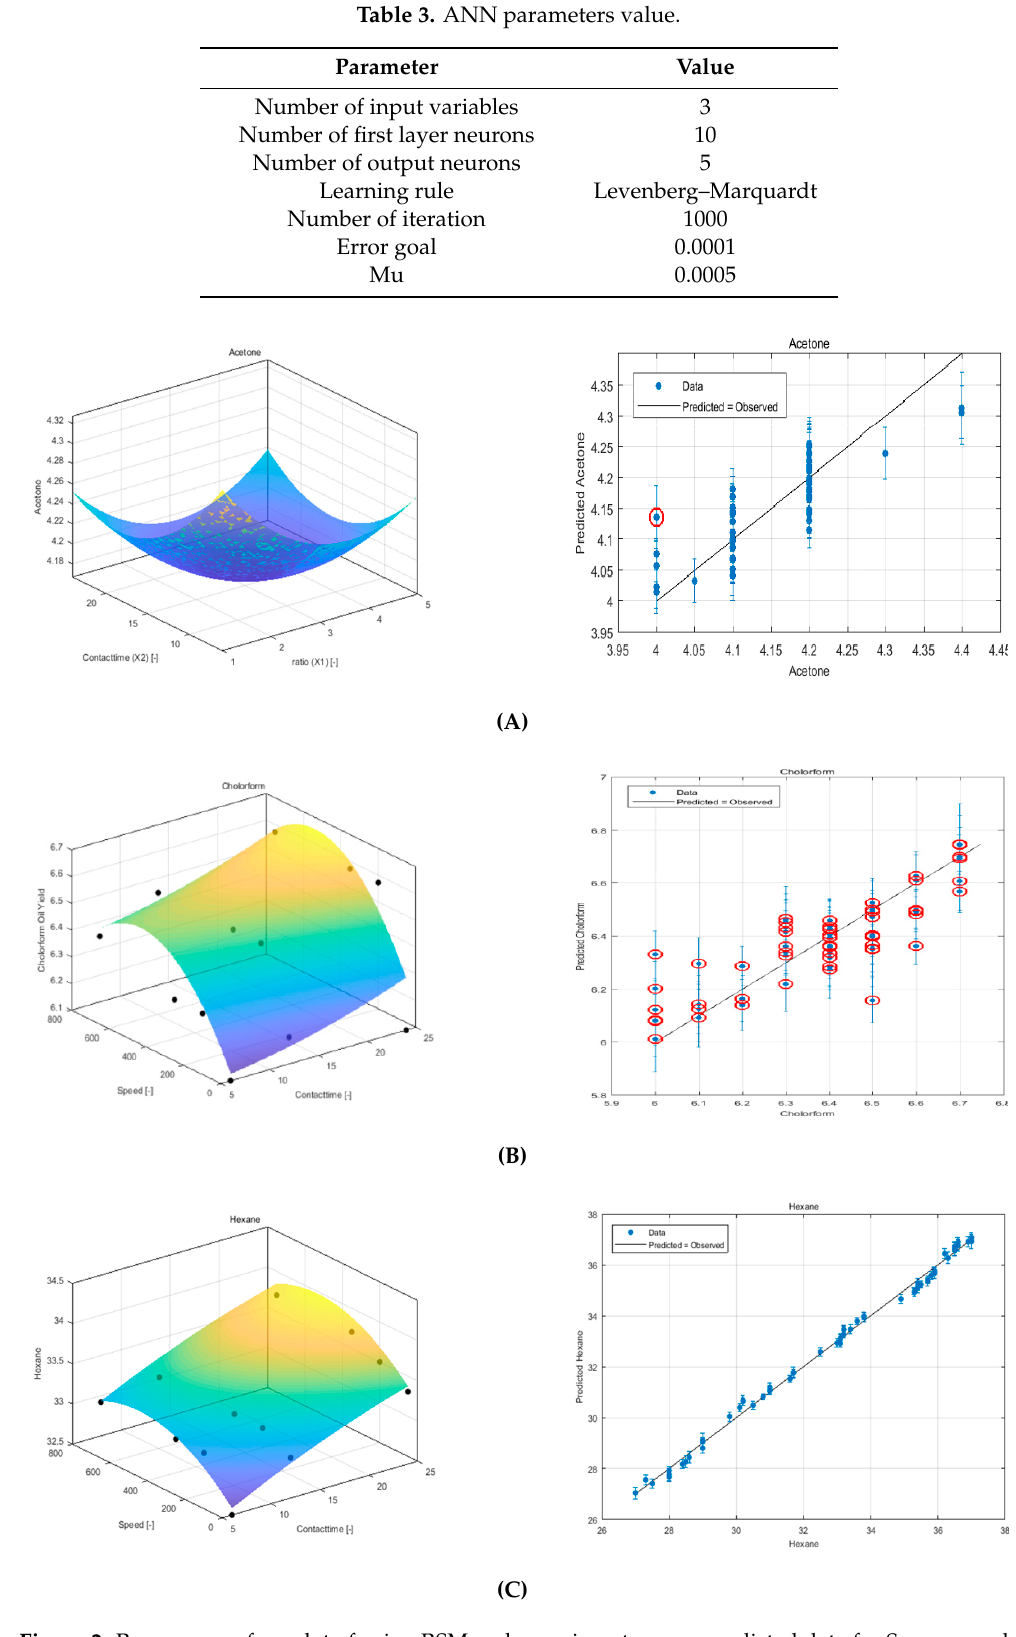
Figure 2. Response surface plot of using RSM and experiment versus predicted data for Sesame seeds oil extraction using ( A ) acetone, ( B ) chloroform, and ( C ) hexane.